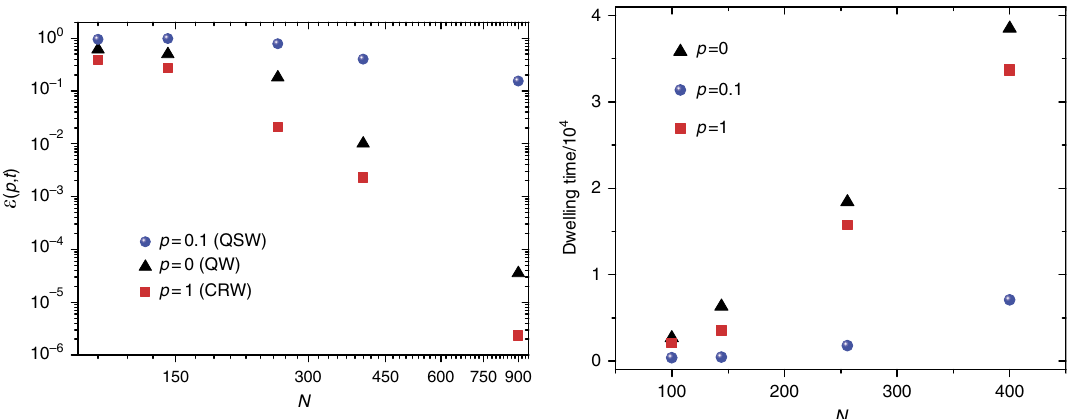
Figure 2 | Transport efficiency for different sizes. Left: Transfer efficiency E p ; t ð Þ as a function of the size N of the maze, for a time scale t linearly increasing with N , that is, t ¼ 10 N . For a maze with N ¼ 900 nodes, the optimal mixing p C 0.1 provides a transfer efficiency that is about five orders of magnitude larger than the perfectly coherent (quantum, that is, p ¼ 0) and fully noisy (classical, that is, p ¼ 1) regimes. The trend of the curves with the maze complexity N , for the different values of p , indicates that even higher speedup can be achieved for increasingly larger mazes. Right: Dwelling time (cid:2) t as a function of the size N of the maze, for p ¼ 0, 0.1,